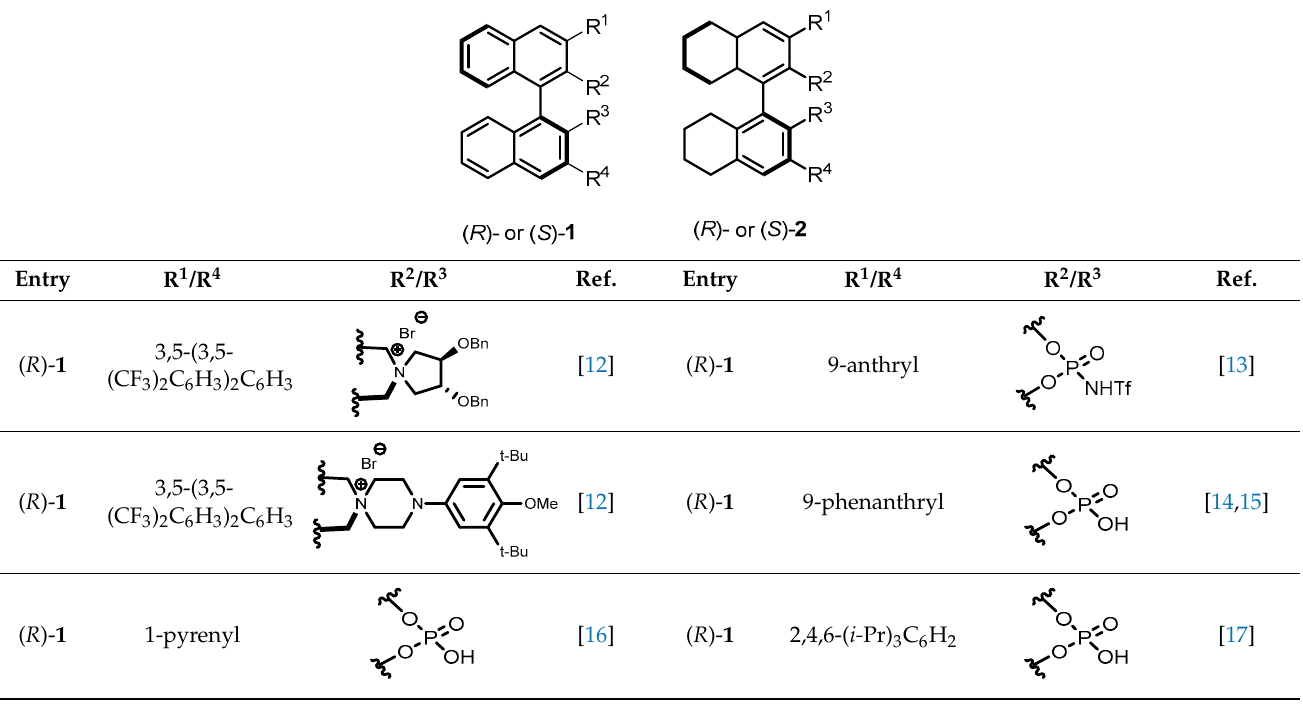
Table 1. Most used catalysts for axial chirality transfer.